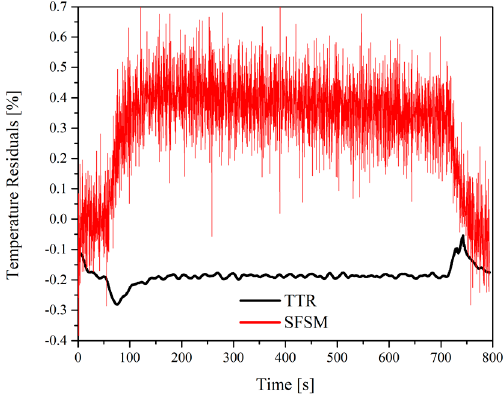
Figure 9. Temperature residuals for both methods.